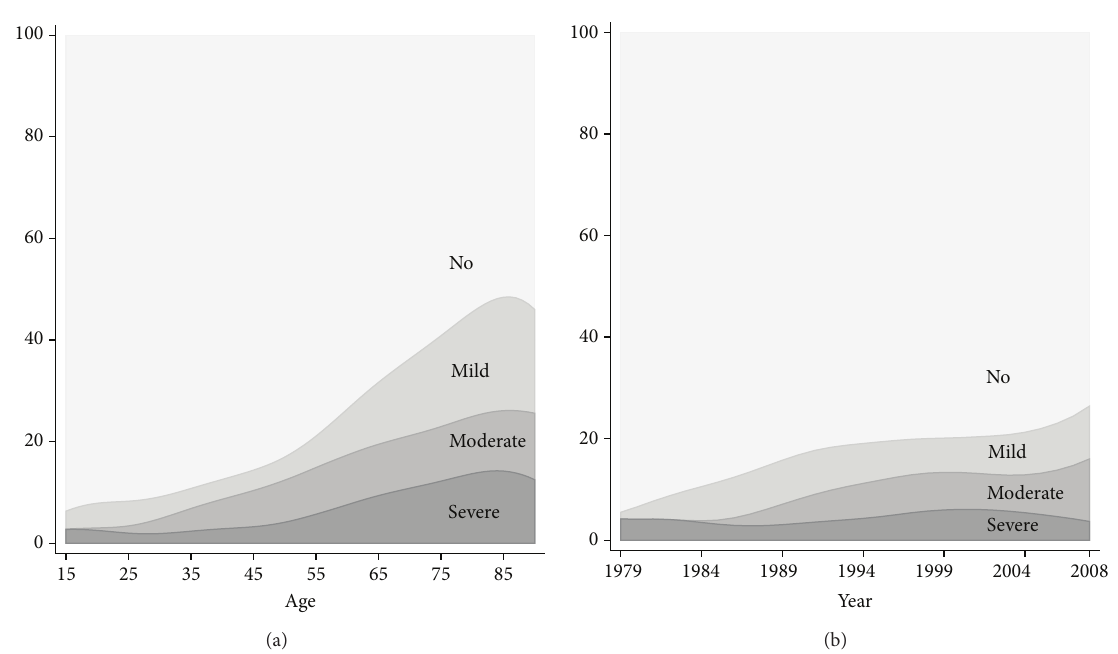
on this basis is